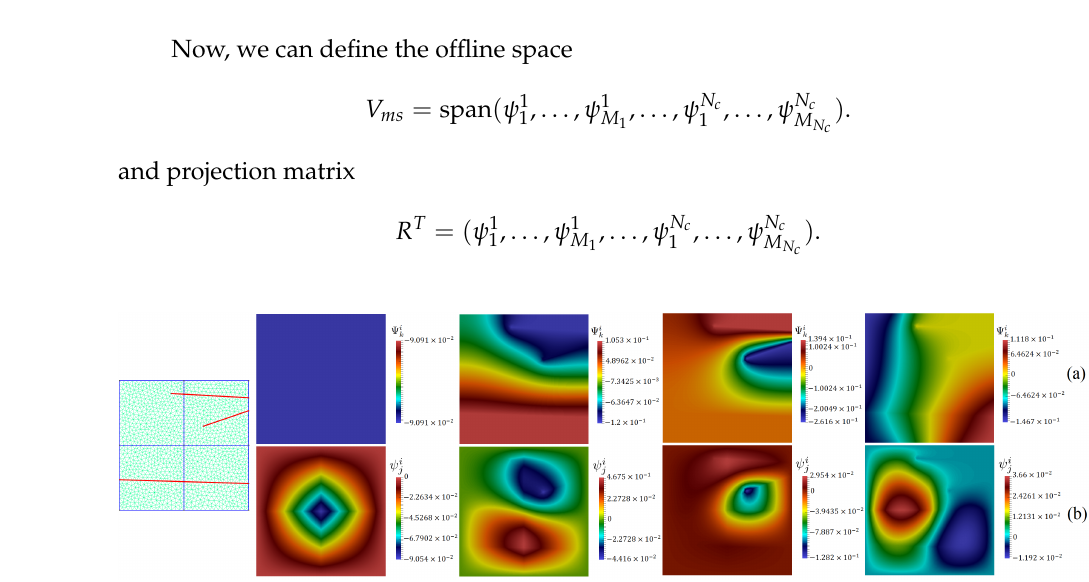
Figure 2. First 4 solution of spectral problem (10) in ω i ( a ) and first 4 offline multiscale basis functions in ω i ( b